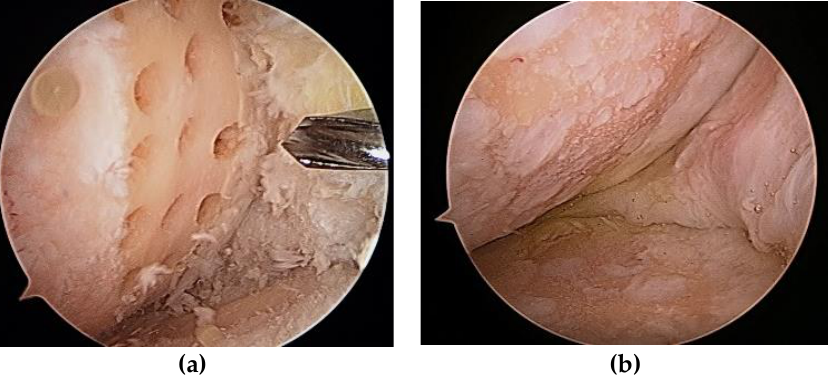
Figure 1. ( a ) Multiple holes drilled into a cartilage defect; ( b ) second-look arthroscopy 2 years later.